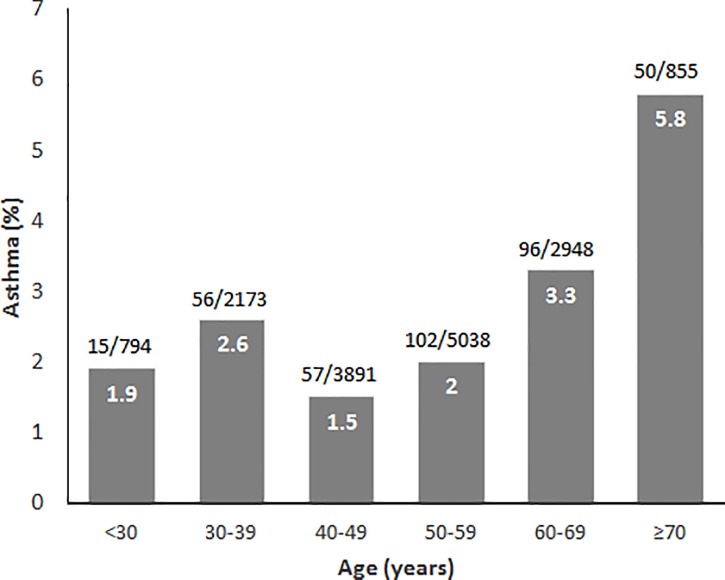
Prevalence of asthma according to age.Asthma prevalence according to age shifted before and after the age of 50. It tended to slightly decrease by age in those under their fifties and since then dramatically increased by age.